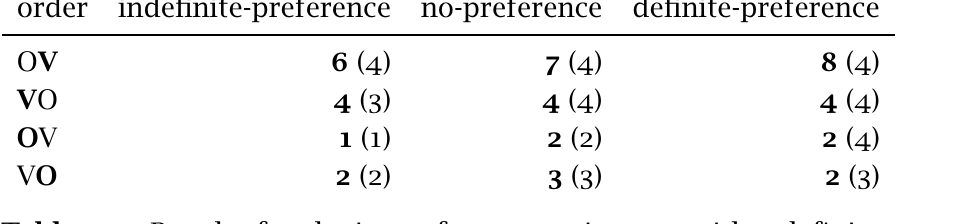
Results for the items from experiment 1 with a definite context, grouped based on the results of the forced choice test; medians in boldface, IQR in parentheses